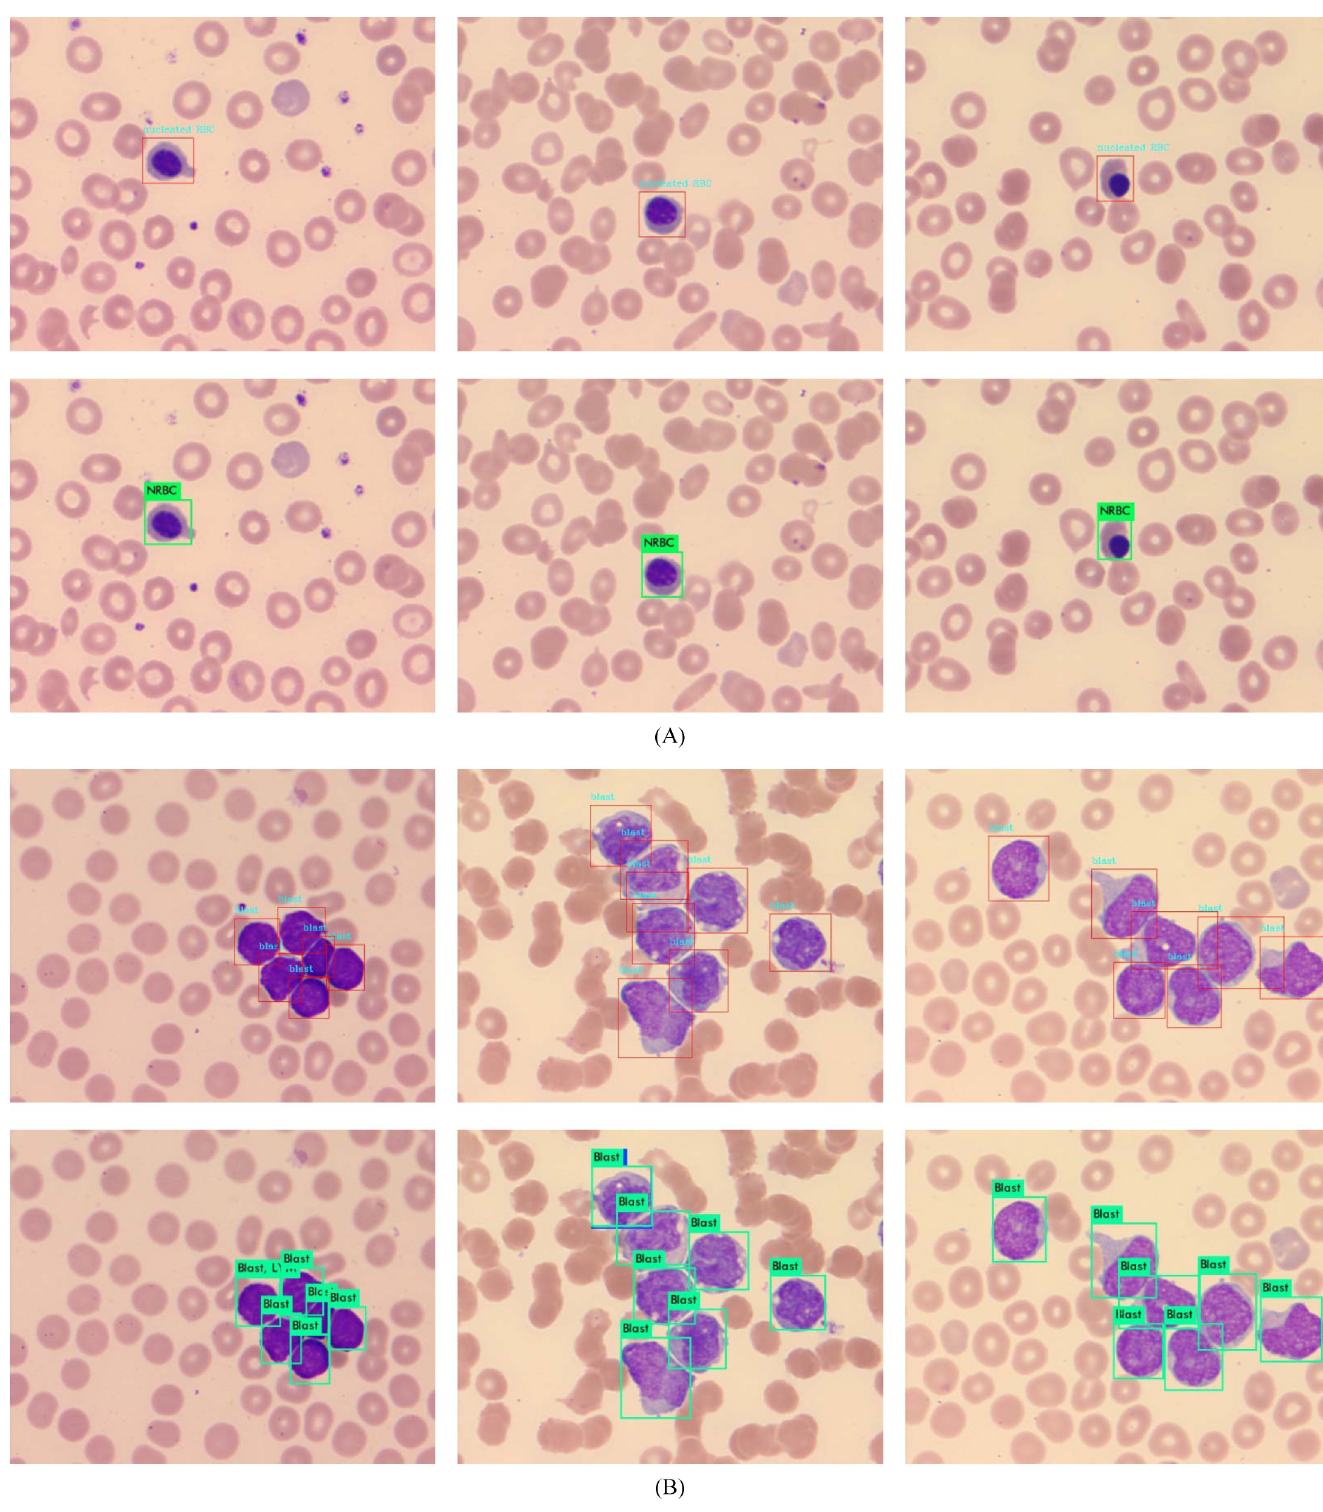
Fig 9. Detection of small cells and dense scenes. (A) NRBC detection where the top was the results of SSD300 × 300_Smin = 0.2 model and the bottom for YOLOv3_320 × 320; (B) leukocytes dense scene detection where the top was the results of SSD300 × 300_Smin = 0.2 model and the bottom for YOLOv3_320 × 320.